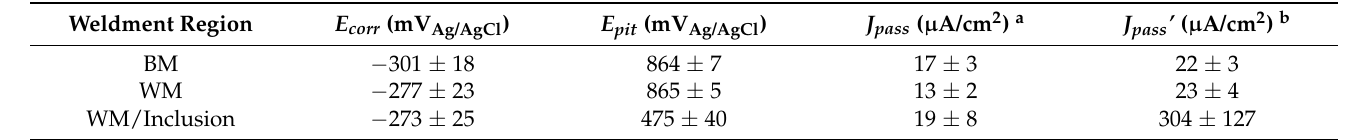
Figure 8. Potentiodynamic polarization curves obtained in 0.6 M NaCl solution for the distinct regions of the multi-pass shielded metal arc welded CW6MC butt joint. Table 4. Electrochemical corrosion parameters obtained from potentiodynamic polarization curves in a stagnant and naturally aerated 0.6M NaCl solution at environmental